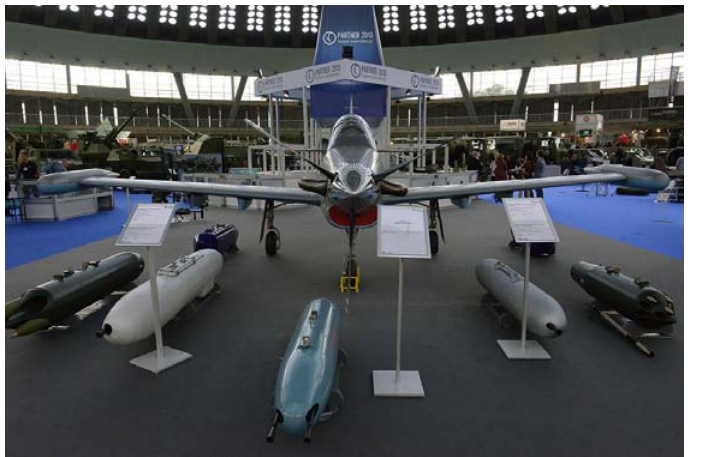
Рис . 3 – Прототип учебно - боевого самолета „ КОБАЦ “ (Yugoipmort SDPR, 2019) Слика 3 – Прототип школско - борбеног авиона „ КОБАЦ ” (Yugoipmort SDPR,